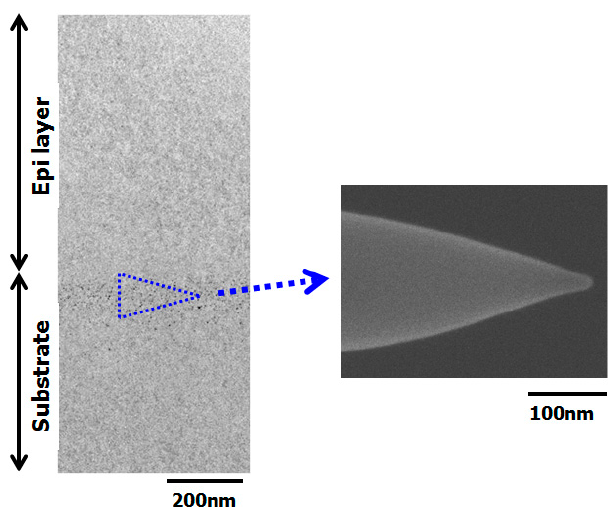
Figure 15. Cross-sectional SEM observation result for atom probe tomography (APT) needle-shaped